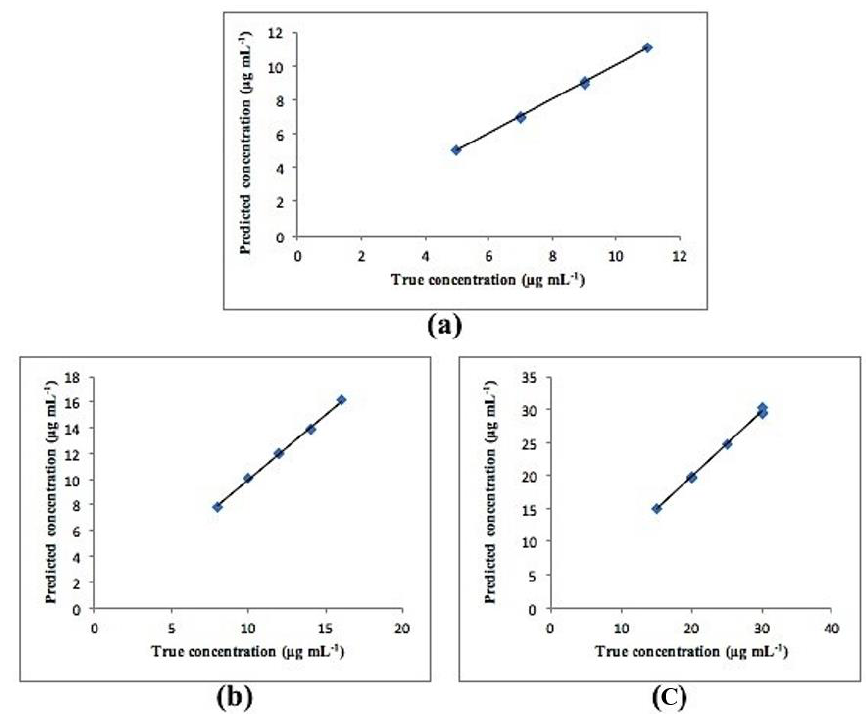
Figure 5. Calibration curve between true and found concentrations for ( a ) CS, ( b ) Deg1 and ( c ) Deg2 for PCR model.